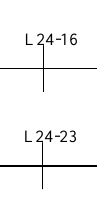
Figure 9. The backward reasoning Petri net of B24.